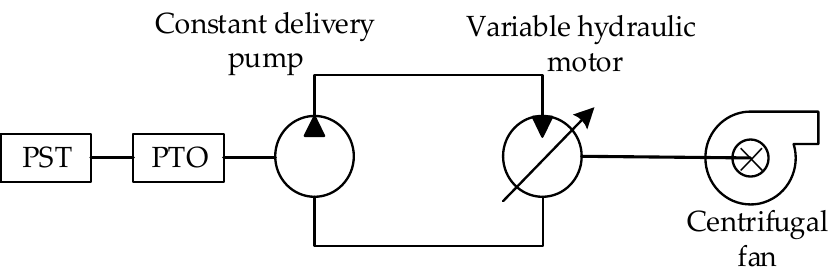
Figure 6. The configuration of power system for centrifugal fan of pneumatic planter.